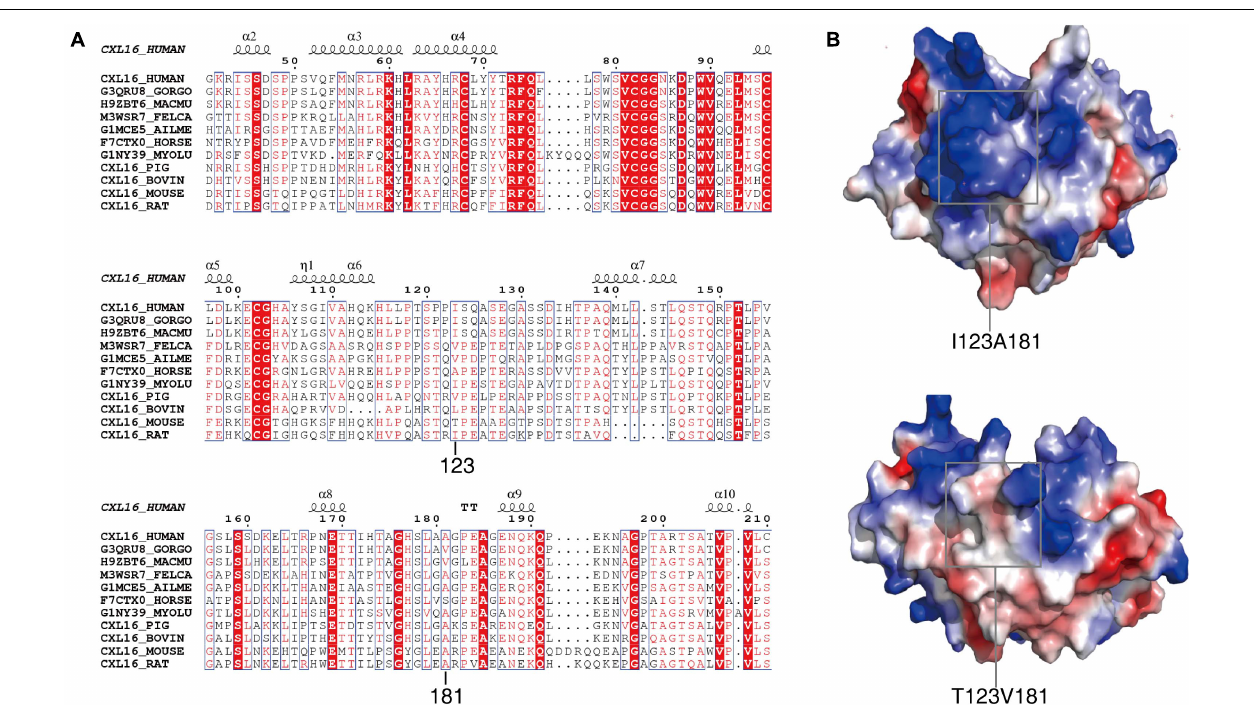
FIGURE 3 | Conservative analysis and molecular modeling of I123T and A181V. (A) Conservative analysis shows that the two missense mutations are both located in the non-conserved region of the CXCL16 gene. (B) The structural diagram shows that the active center of the CXCL16 protein was changed by V → A substitution, which might make the active center of the CXCL16 protein